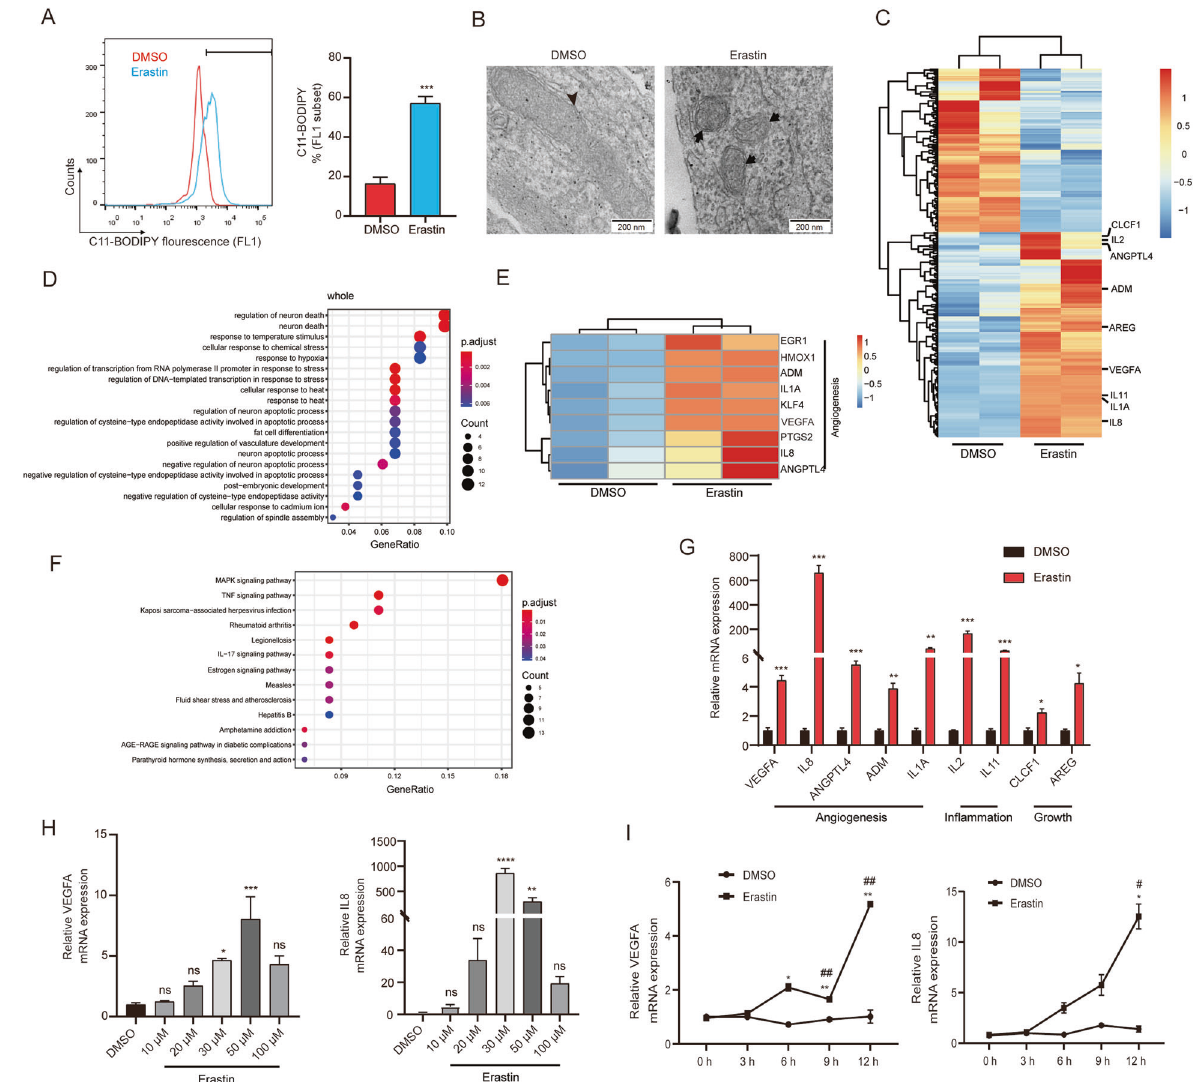
Fig. 2 Transcription pro fi les and veri fi cation of erastin-treated ESCs. Primary ESCs were treated with erastin (30µM) or DMSO for 12h. A Lipid ROS levels were assessed using fl ow cytometry and C11-BODIPY. Representative data and statistical analyses from three independent experiments are shown. B Transmission electron microscopy analysis of mitochondria ultrastructure in ESCs under erastin treatment. C Heatmap displaying a subset of DEGs in ESCs treated with 30µM erastin for 12h ( ≥ 2 ‐ fold, P < 0.05). GO ( D ) and KEGG pathway enrichment ( F ) analyses on DEGs in response to erastin-induced ferroptosis. E Heatmap of angiogenesis-related DEGs. G RT-qPCR analysis was used to validate the DEGs, which included angiogenic cytokines (VEGFA, IL8, ANGPTK4, ADM, and IL1A), in fl ammatory (IL2 and IL11) and growth factors (CLCF1 and AREG) ( n = 3, compared with DMSO). H , I The ESCs were treated with erastin at different concentrations (10, 20, 30, 50, and 100 µM) for 12 h and for different time periods (0, 3, 6, 9, and 12h) using 30µM erastin. VEGFA and IL8 mRNA expressions were detected using RT-qPCR and statistical analysis from three independent experiments. * Compared with DMSO, # compared with 0 h. Arrowheads indicate deformed mitochondrial structures, while arrows point to normal mitochondrial structures. Comparisons were made using the two-tailed, Student ’ s t test ( A , G ), one-way ANOVA ( H ) and two-way ANOVA ( I ). * P < 0.05, ** P < 0.01, *** P < 0.001, **** P < 0.0001, # P < 0.05, ## P < 0.01. ns not statistically signi fi cant, ESCs endometrial stromal cells, DMSO dimethyl sulphoxide, ROS reactive oxygen species, GO Gene Ontology, KEGG Kyoto Encyclopaedia of Genes and Genomes,